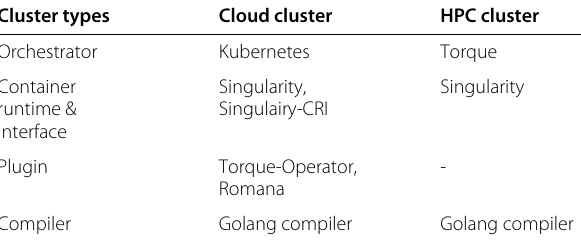
Table 4 Technical Specifications of the testbed Table 5 The list of core applications for the